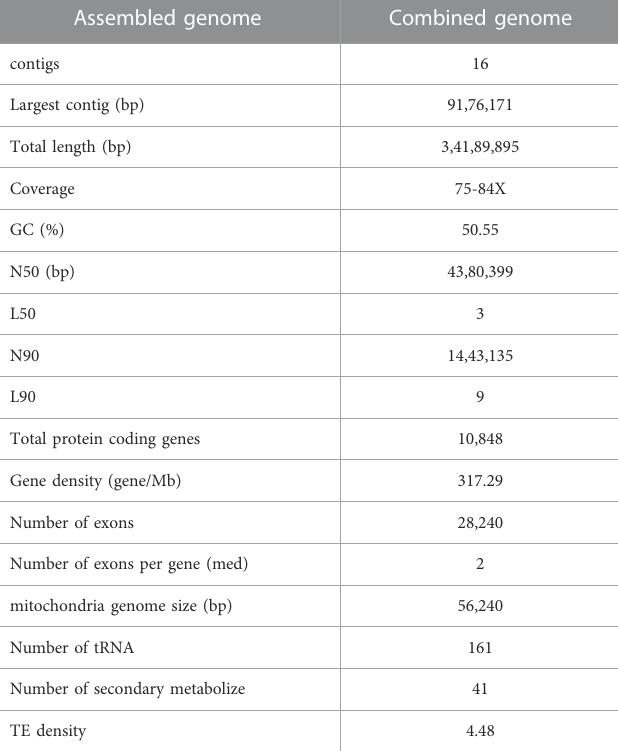
TABLE 1 Genome assembly of Beauveria bassiana (Bb-NCHU-157).